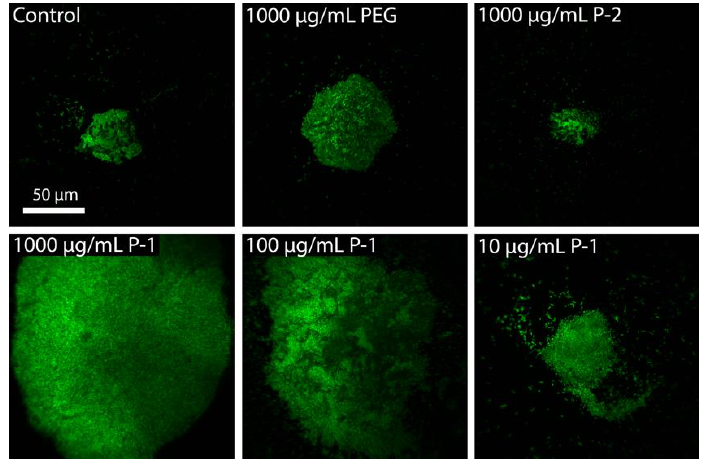
Figure 5. Representative images depicting aggregates of 1.0 OD 600 solutions following 15 min incubation with polymers solutions in PBS.